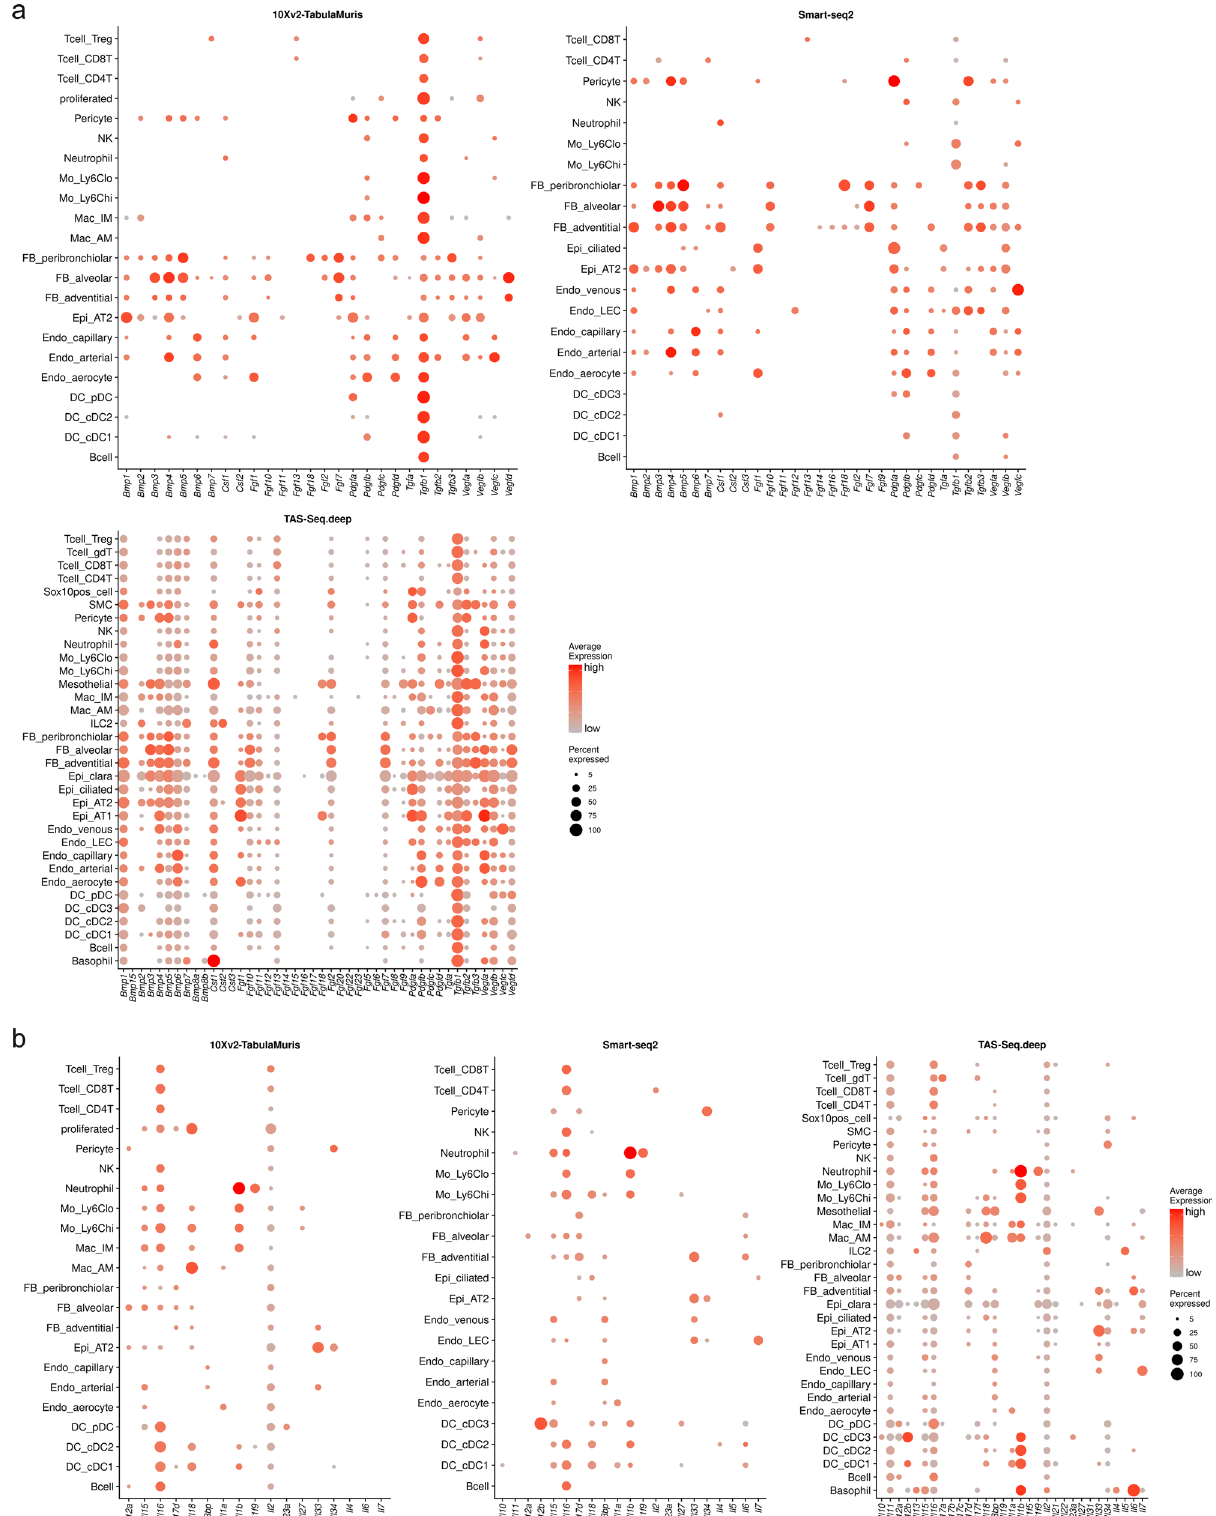
Fig. 6 Expression patterns of growth factors and interleukins in TAS-Seq, 10X v2, and Smart-seq2 data from each cell subset of murine lung tissue. a , b Dot plots show expression patterns of selected growth factors — fi broblast growth factors (FGFs), bone morphogenic proteins (BMPs), platelet-derived growth factors (PDGFs), transforming growth factors (TGFs), vascular endothelial growth factors (VEGFs), and colony-stimulating factors (CSFs) ( a ) — and interleukins ( b ) in each lung cell subset in TAS-Seq (deep-sequenced), 10X v2 (Tabula Muris), and Smart-seq2 datasets. Colors represent expression level, and size of the dots represents the percent of expressed